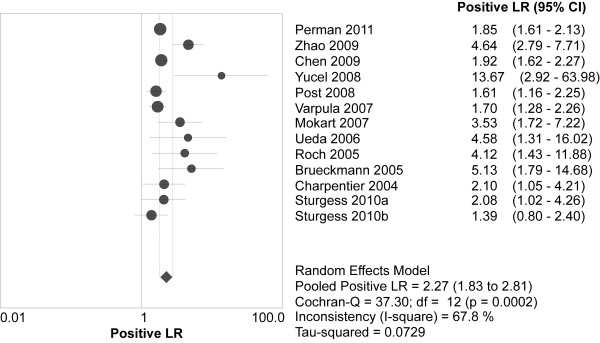
Summary of the positive likelihood ratio of elevated BNP or NT-proBNP in predicting mortality. BNP = brain natriuretic peptide, NT-proBNP = N-terminal pro-B-type natriuretic peptide.